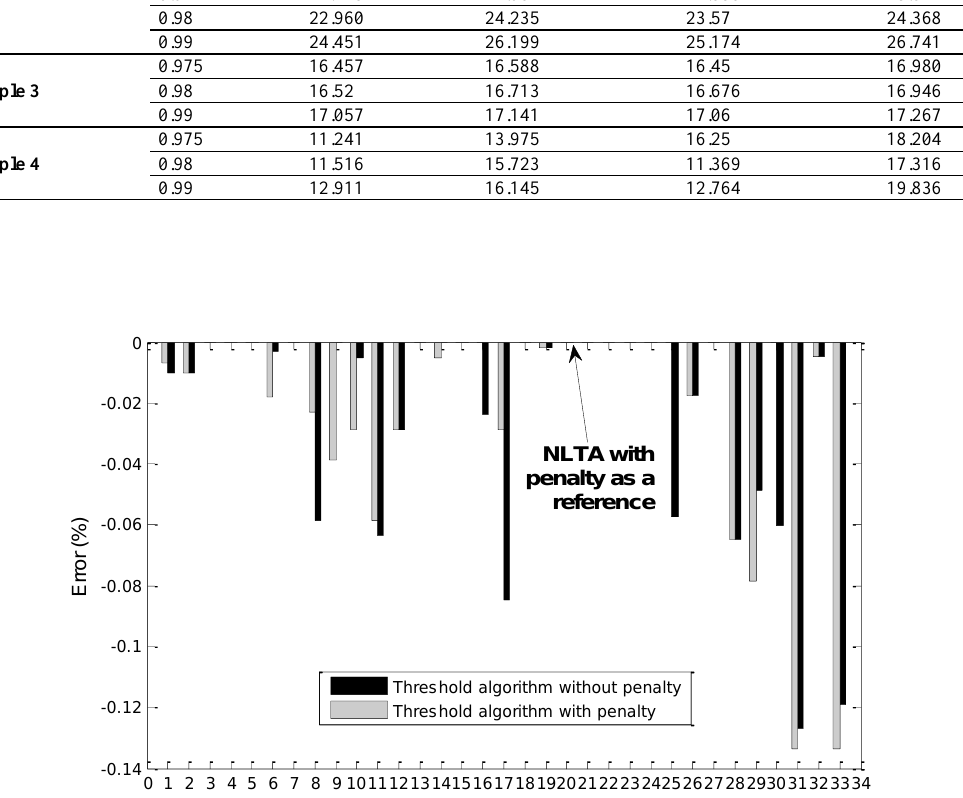
Figure 5. Comparing threshold algorithm with and without penalty in case of binary-state systems.